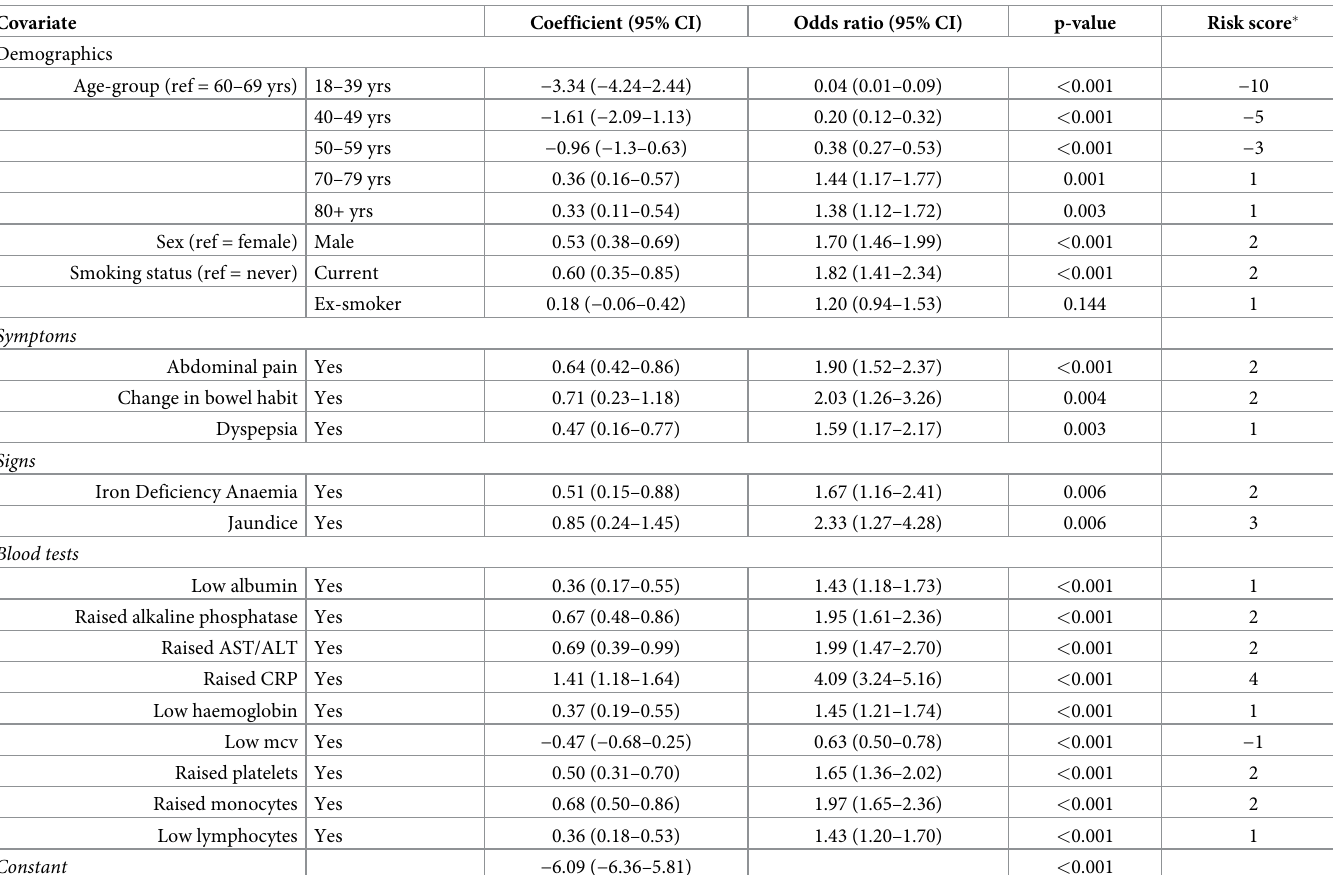
Table 3. STm—Symptoms and test model.